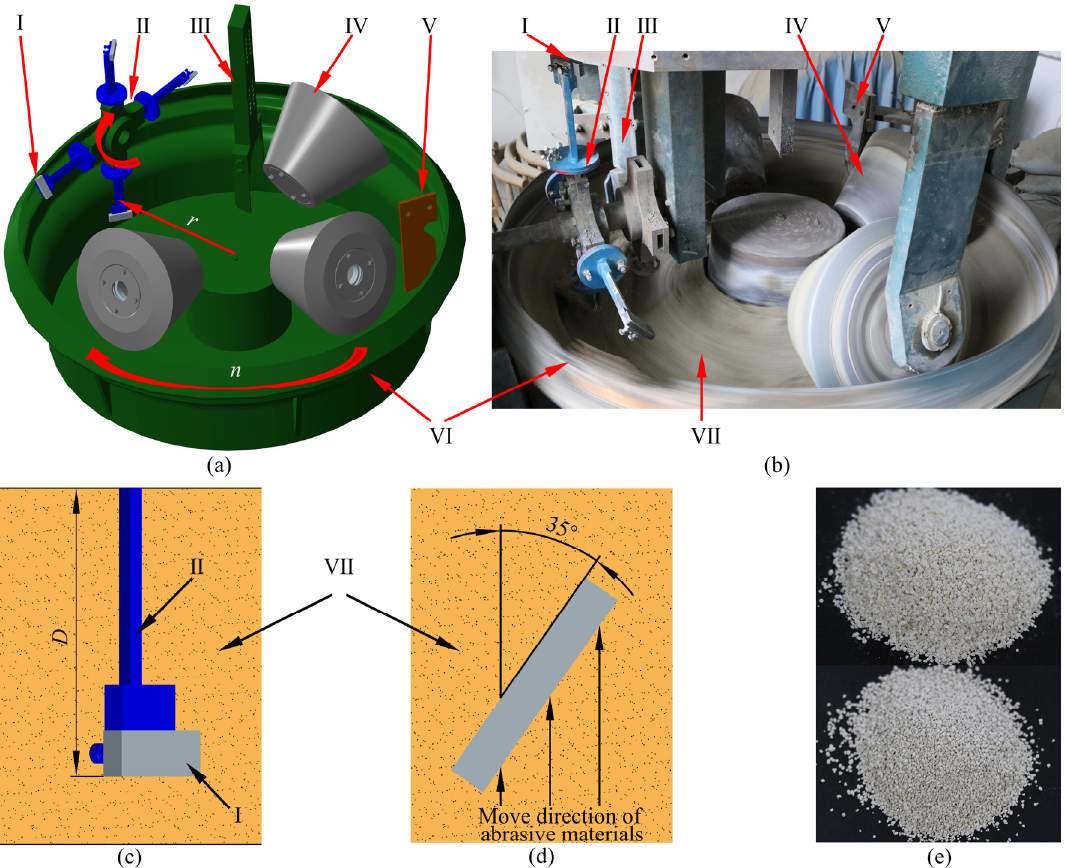
Figure 2. 3D model ( a ) and photo ( b ) of the key components on JMM abrasive wear tester, diagram of the depth of the specimen in abrasive materials ( c ) and the impact angle of abrasive material against specimen surface ( d ) and the dry abrasive materials before ( top ) and after ( bottom ) the tests ( e ). ( Ⅰ ) Specimen, ( Ⅱ ) specimen holder, ( Ⅲ ) subsoiler, ( Ⅳ ) press roller, ( Ⅴ ) scraper, ( Ⅵ ) rotary bin, ( Ⅶ ) abrasive materials, n the rev of rotary bin, r = 400 mm the distance between the mounting position of specimens and the spindle of rotary bin, and D = 80 mm the depth of the specimen in abrasive materials.